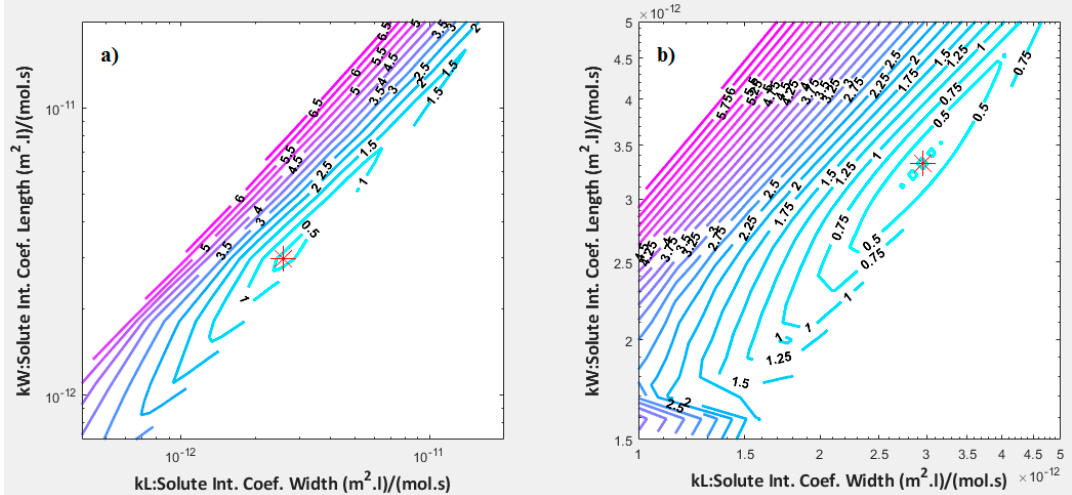
Figure 5. Two-tier parameter estimation. Plot of total error versus k W and k L . (( a ) low-resolution scan of entire range of values of k W and k L , ( b ) high-resolution scan in an area of location of global minima of the total error. Asterix in ( b ): Location of the global minima of the objective function).